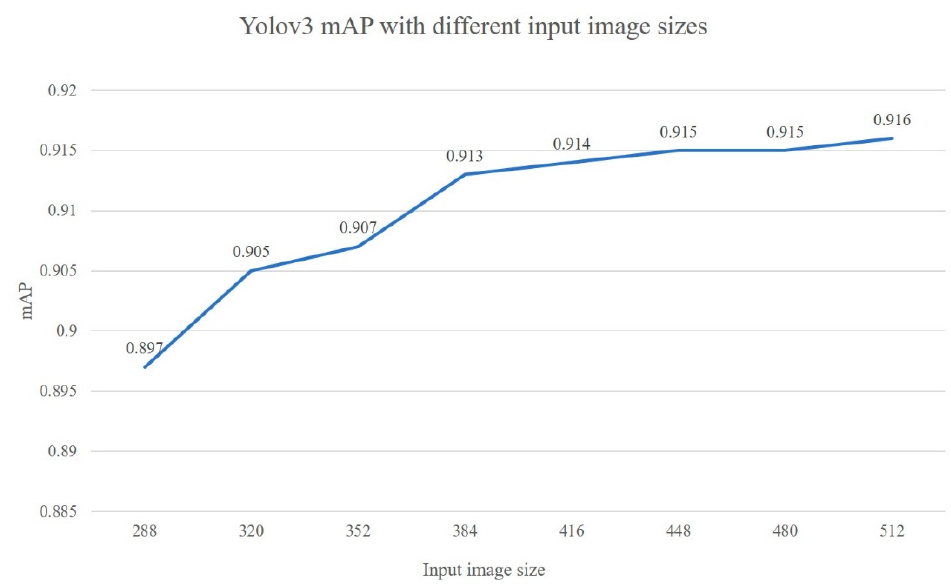
Figure 3. The mAP of Yolov3 with different input image sizes.